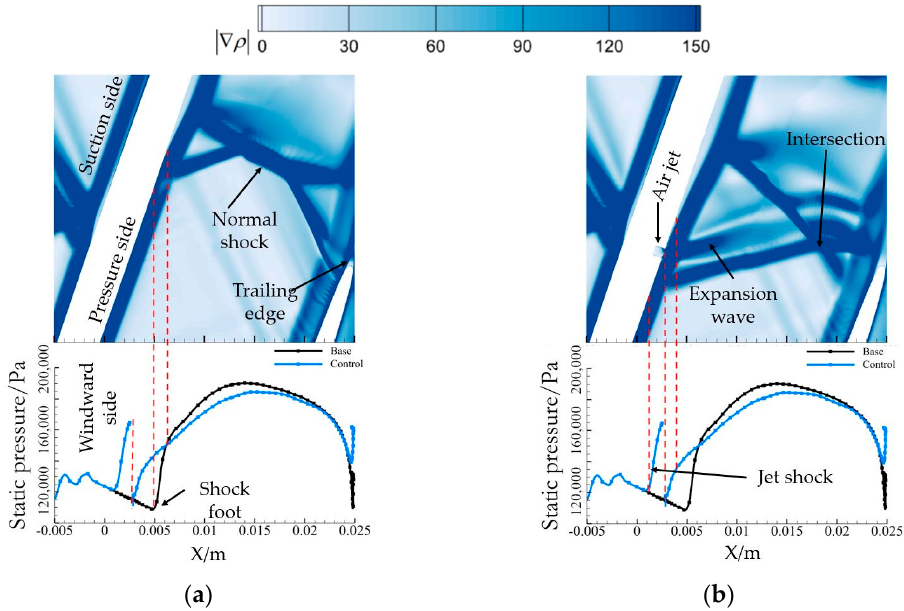
Figure 5. Local enlargement near the trailing-edge shock and the corresponding static pressure distribution on blade surface: ( a ) baseline case; ( b ) controlled case.